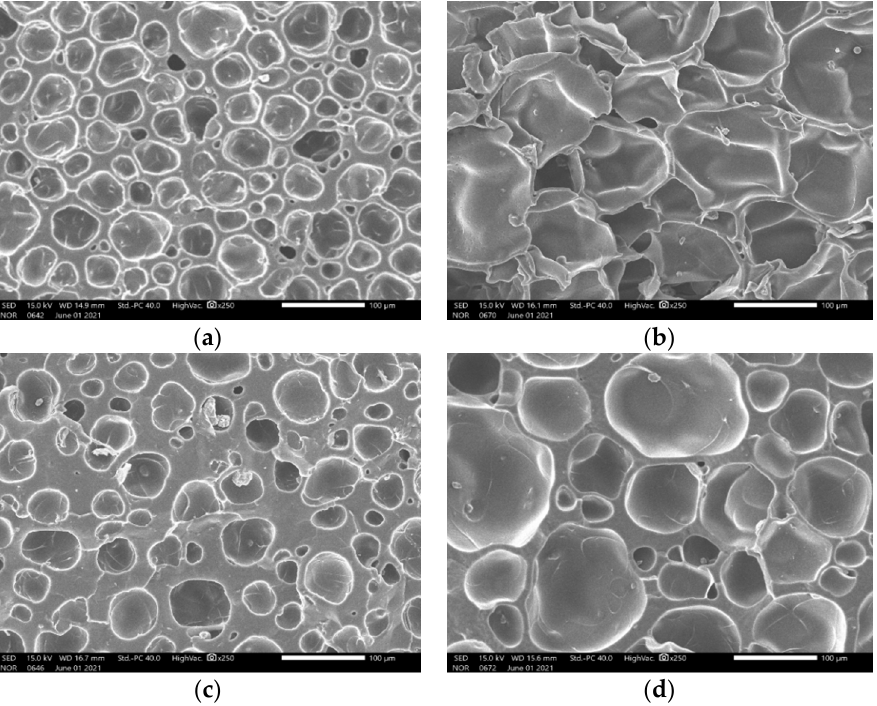
Figure 4. Scanning electron micrograph of ceramic urethane specimens for low-frequency measure- ments: ( a ) Microcellular foamed at 150 °C and 30 s (at a magnification of ×250); ( b ) Microcellular foamed at 150 °C and 90 s (at a magnification of ×250); ( c ) Microcellular foamed at 170 °C and 30 s (at a magnification of ×250); ( d ) Microcellular foamed at 170 °C and 90 s (at a magnification of ×250).